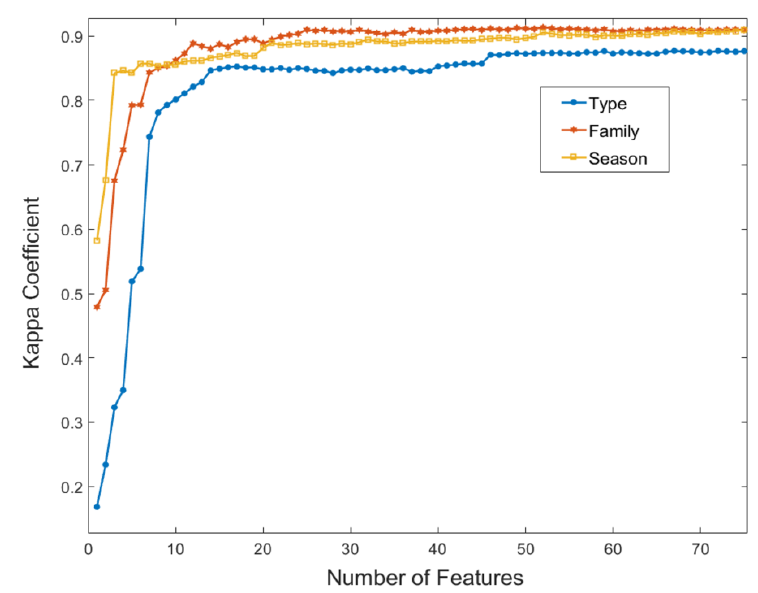
Figure 9. Kappa coefficient evolution for all levels of nomenclature using the SVM classifier.